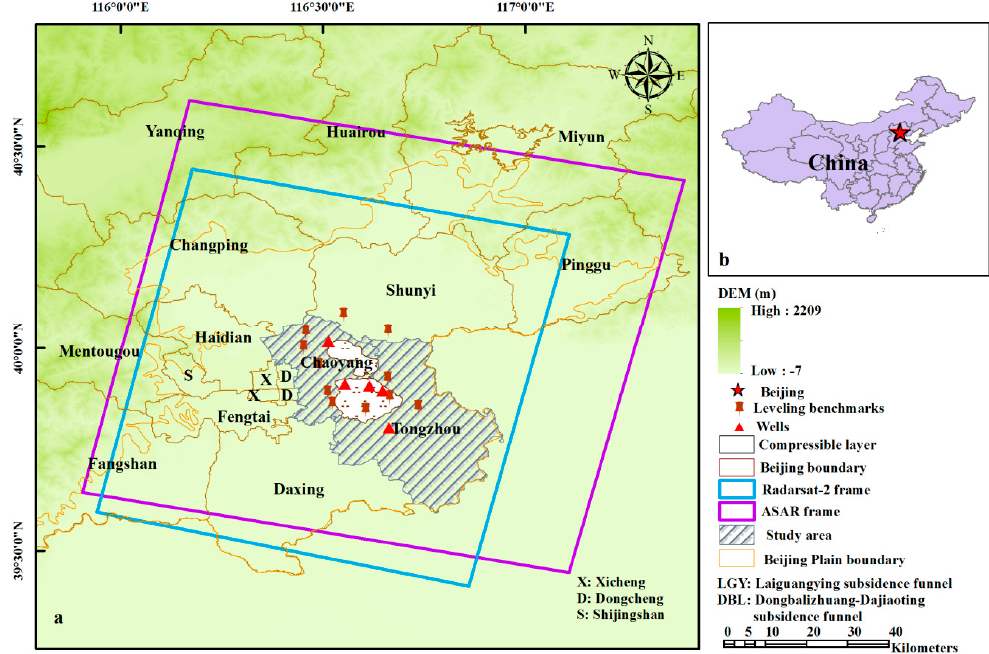
Figure 1. The geographical location of the study area. The violet box and blue box represent the ASAR and Radarsat-2 data spatial coverage, respectively. The colored pushpins indicate the locations of the leveling benchmarks. The red points represent the locations of wells and are named JingshunLu (JSL), Dengfuzhuang (DFZ), Baliqiaocun (BLQ), Luhe middle school (LHZ), and Nanhuofa (NHF) in the study area.